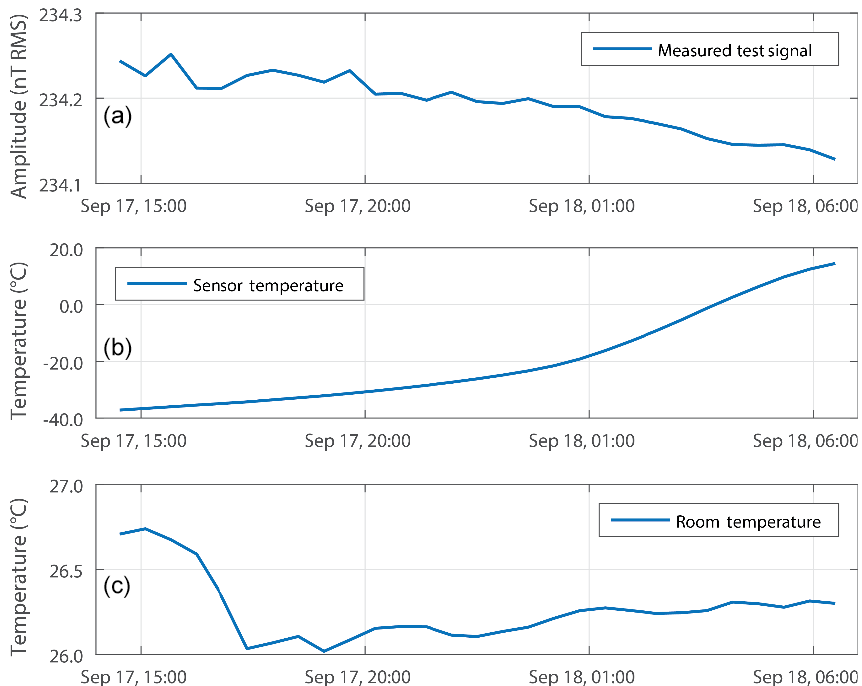
Figure 12. Trial one for MACOR/MACOR sensor. (a) Amplitude of applied sinusoidal test signal measured by the value of the 1Hz bin the